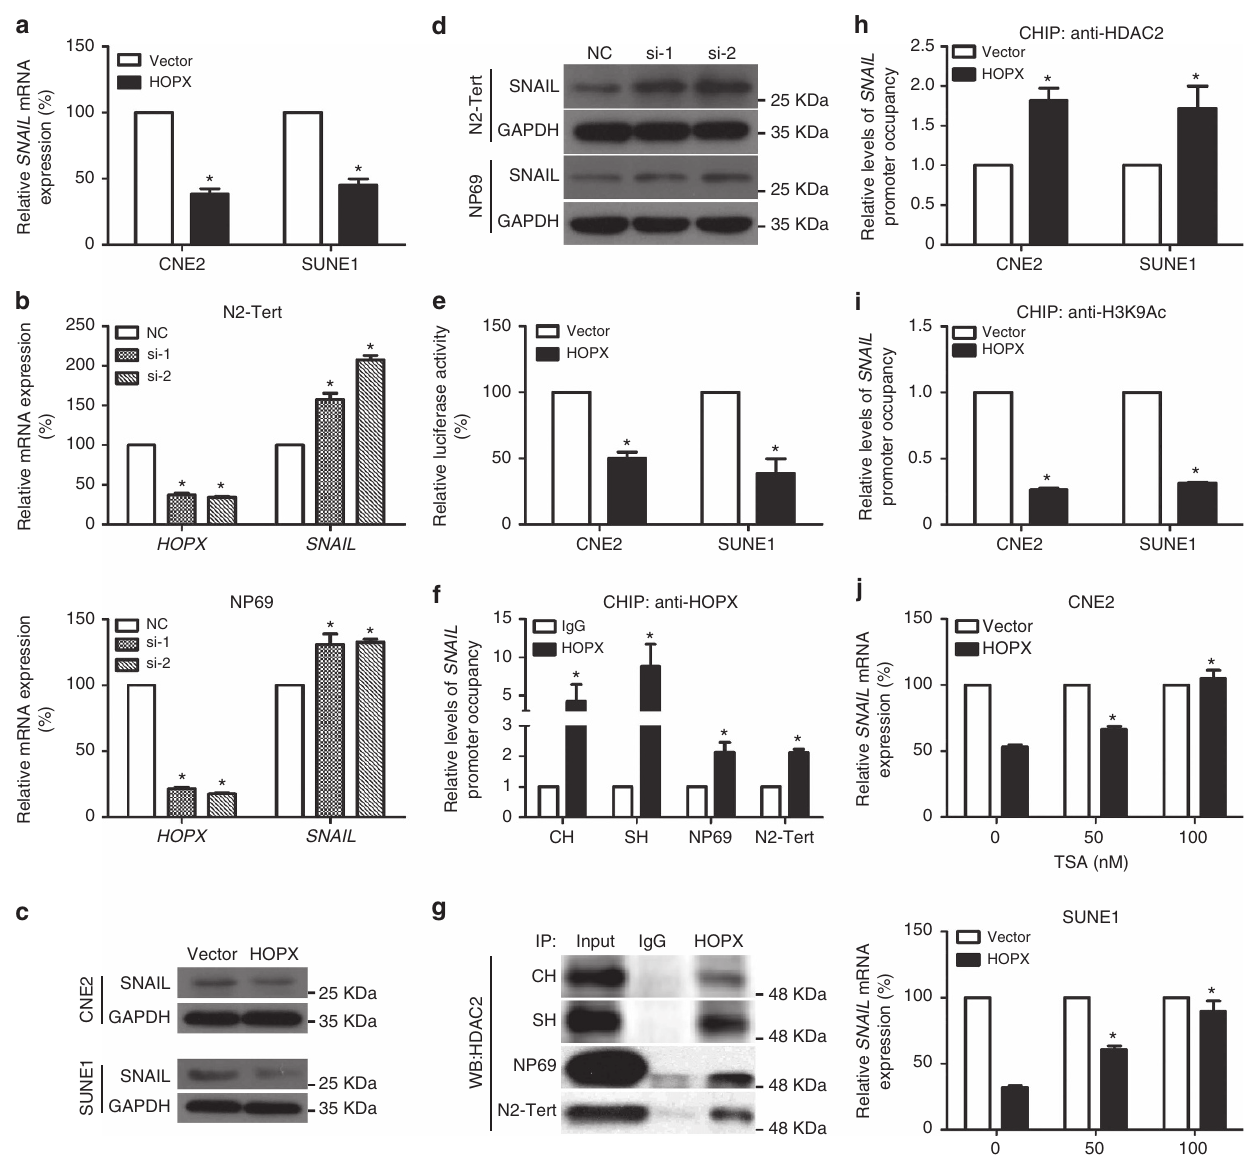
Figure 5 | HOPX recruits HDAC activity to the SNAIL promoter and epigenetically suppresses SNAIL transcription in NPC. ( a – d ) Real-time RT–PCR ( a , b ) and western blotting ( c , d ) assays were used to examine the mRNA and protein levels of SNAIL in CNE2 and SUNE1 cells stably overexpressed the vector or HOPX, or N2-Tert and NP69 cells transfected with the control NC or HOPX -siRNAs (si-1 and si-2). Mean ± s.d.; * P o 0.01 compared with vector or NC; Student’s t -tests. ( e ) CNE2 and SUNE1 cells with transfection of the pGL3- SNAIL promoter were co-transfected with the vector or HOPX and subjected to dual-luciferase reporter assays. Mean ± s.d.; * P o 0.01 compared with vector; Student’s t -tests. ( f ) ChIP real-time PCR assays were conducted to assess the enrichment of HOPX in the SNAIL promoter region in CH, SH, NP69 and N2-Tert cells. Mean ± s.d.; * P o 0.01 compared with IgG; Student’s t -tests. ( g ) Physical interactions between HOPX and HDAC2 were examined via a Co-IP assay in CH, SH, NP69 and N2-Tert cells; WB: western blotting assay. ( h , i ) ChIP real-time PCR assays were applied to measure the enrichment of HDAC2 ( h ) and H3K9Ac ( i ) in the SNAIL promoter of CNE2 and SUNE1 cells stably overexpressed the vector or HOPX. Mean ± s.d.; * P o 0.01 compared with vector; Student’s t -tests. ( j ) Real-time RT–PCR was conducted to assess the relative SNAIL mRNA expression in CNE2 and SUNE1 cells stably overexpressed the vector or HOPX that were treated with TSA (0, 50 or 100nM). Mean ± s.d.; * P o 0.01 compared with TSA (0nM); Student’s t -tests. CH and SH cells indicated CNE2 and SUNE1 cells with stable HOPX overexpression. These data are representative of three independent